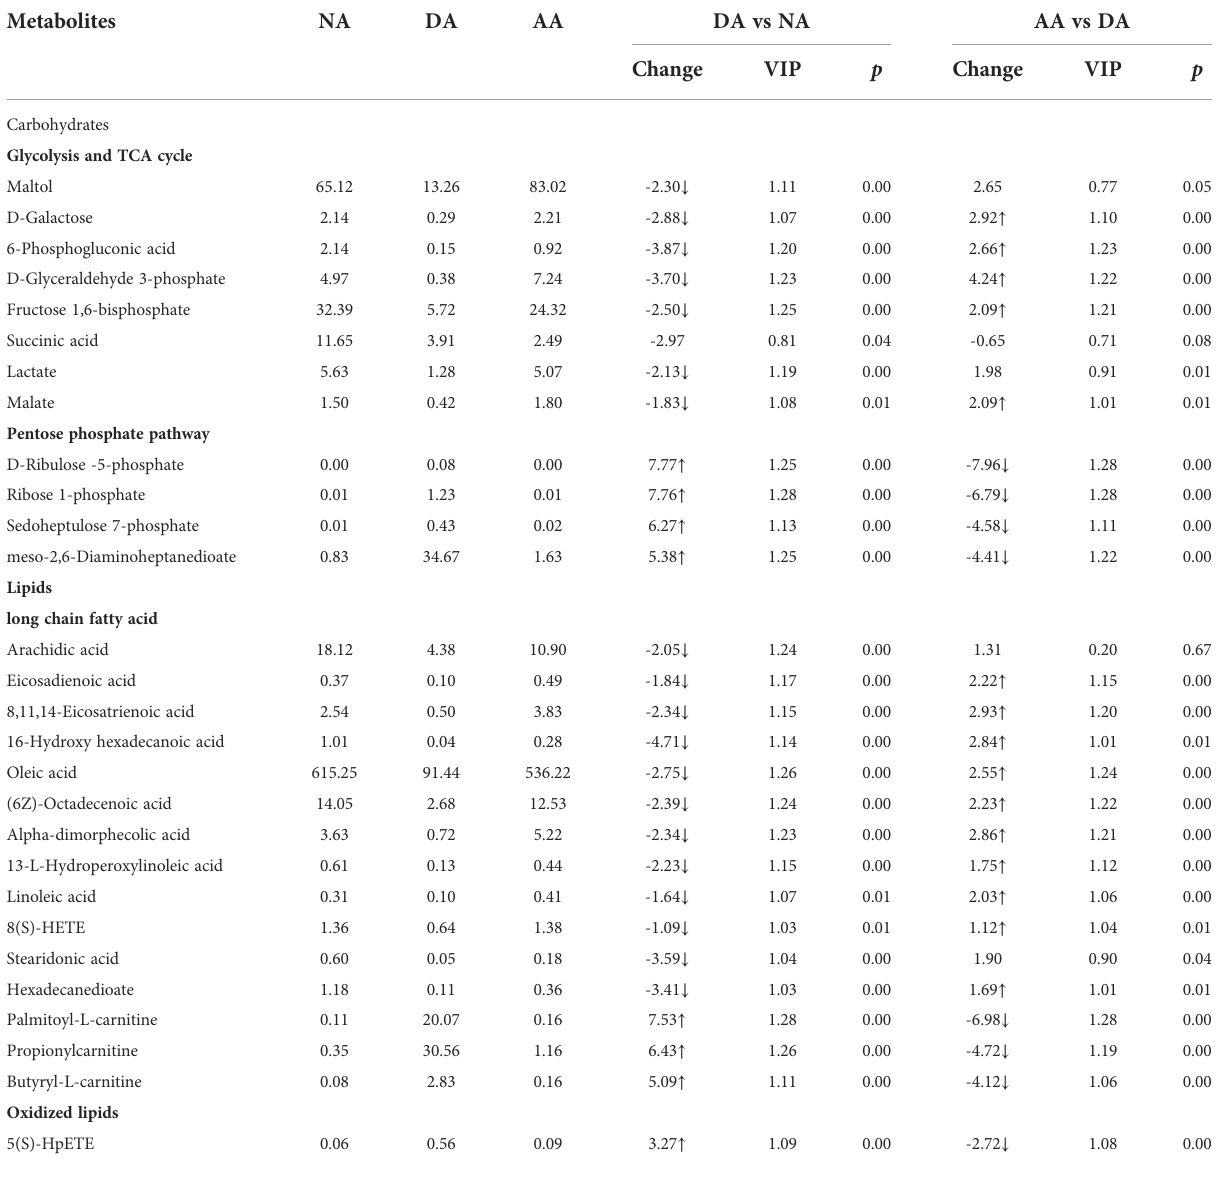
TABLE 1 Important differential metabolites in A. japonicus during estivation